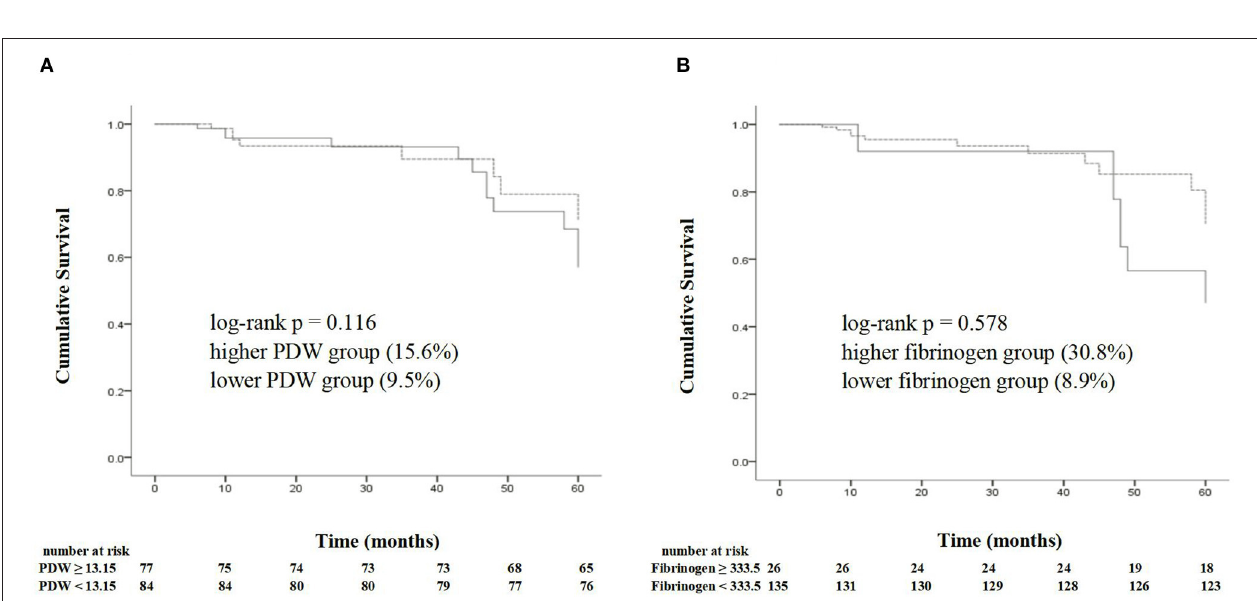
FIGURE 4 | The Kaplan–Meier analysis shows the cumulative survival of target lesion failure according to the cutoff points of a PDW of 13.15% (A) and a fibrinogen of 333.5 mg/dl (B) . PDW, platelet distribution width.